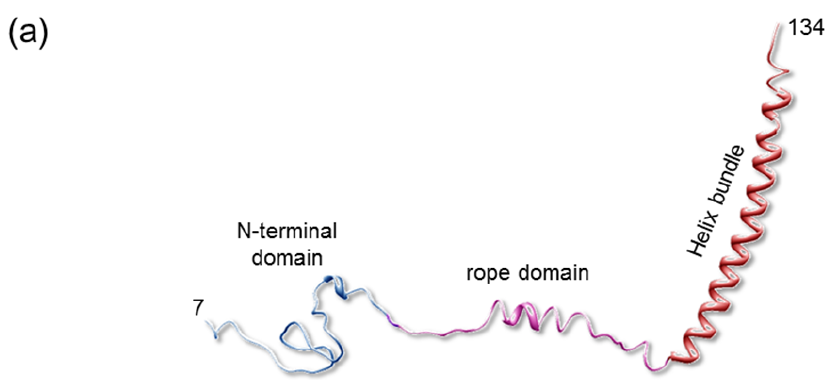
Figure 6. Polypeptide IX structure and conservation. ( a ) The extended fold of polypeptide IX is shown as a ribbon, with the different domains labeled and depicted in different colors. ( b ) Alignment of representative polypeptide IX sequences for the different species in the Mastadenovirus genus. In the bottom line the extent of the N-terminal (N), rope (r) and helix bundle (H) domains from the HAdV-5 structure are indicated with letters in the same color used for each domain in (a). Notice that the rope domain is conserved only in human and simian viruses (sequences within a black rectangle). Sequences were retrieved from UniProt [143] and aligned with Clustal [144] and JalView [145]. The extra-long PAdV-3 IX sequence is shown truncated for figure